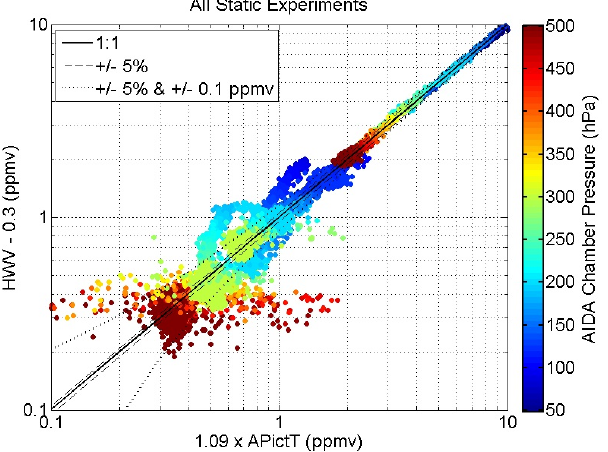
Figure A8. Comparison of HWV and APicT low water vapor data for static experiments. Color indicates chamber pressure. APicT data are multiplied by 1.09 to account for a calibration difference between these two instruments inferred from data acquired during the high water vapor experiments on 16 and 17 October. In addi- tion, a constant offset of 0.3ppmv has been subtracted from HWV. At mixing ratios lower than ∼ 2ppmv and chamber pressures less than ∼ 200hPa, systematic uncertainties associated with low mass flows in the HWV instrument plagued the